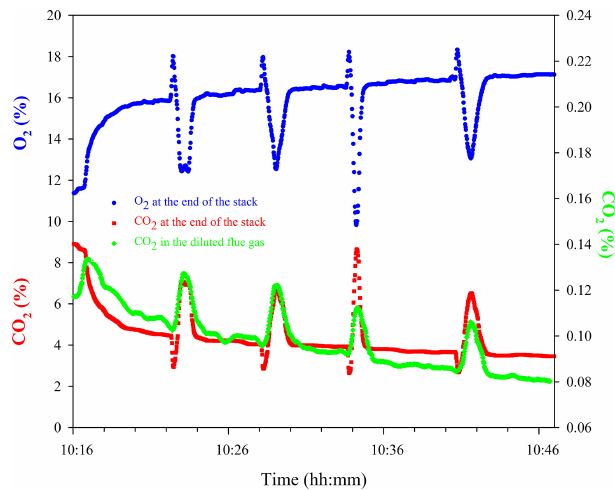
Figure 2. Example (PS-F9 sample) of the variations in the mea- sured CO 2 and O 2 mixing ratios at the end of the stack and the CO 2 mixing ratio in the diluted flue gas during combustions